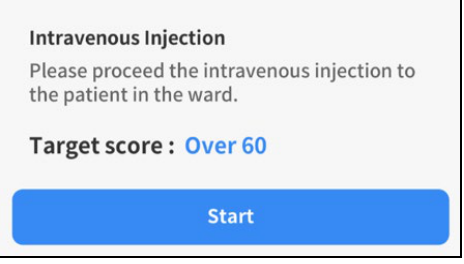
Figure 1. Target score in the VRS for IV injection.